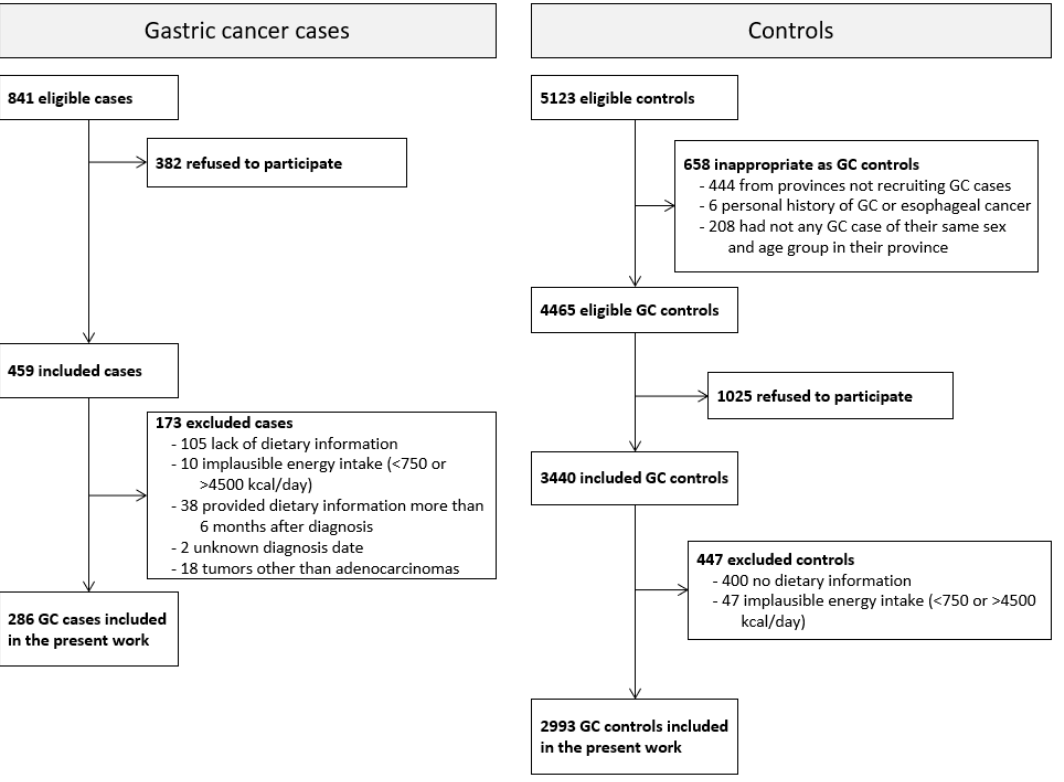
Figure 1. Selection process of gastric cancer cases and controls in the MCC-Spain study from 2008 to 2013.